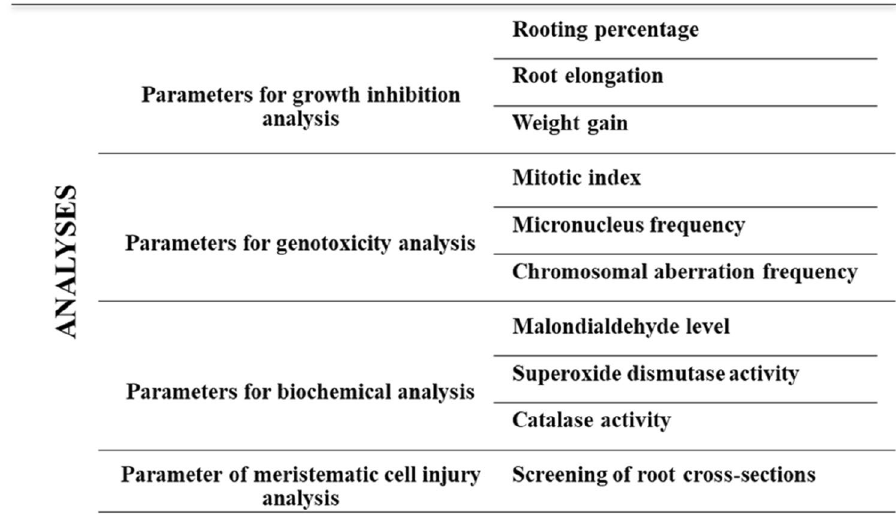
Figure 1. Analysis-parameter relationship in the study